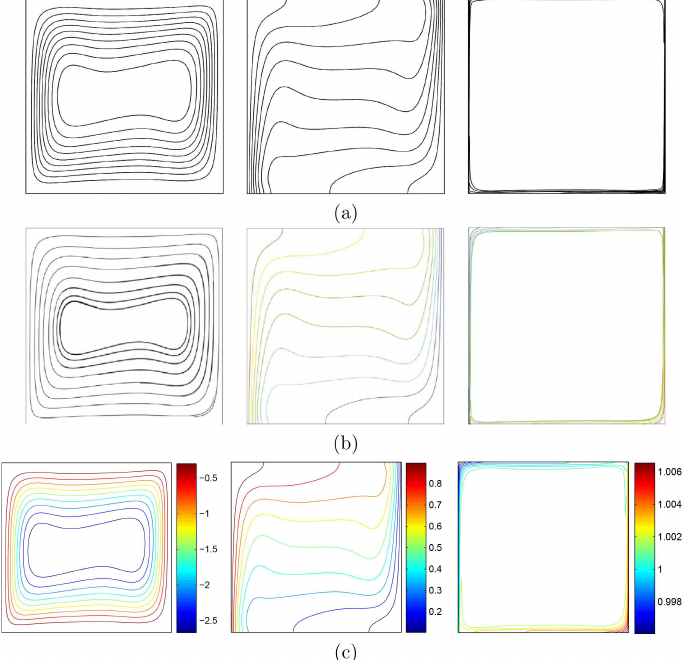
Figure 3. Validations of ( left ) streamlines, ( middle ) isotherms, and ( right ) nanoparticle distribution for ( a ) Corcione et al. [41], ( b ) Wang et al. [42], and ( c ) the present study at Ra = 3.37 × 10 5 , φ = 0.04, N = 0, and R =